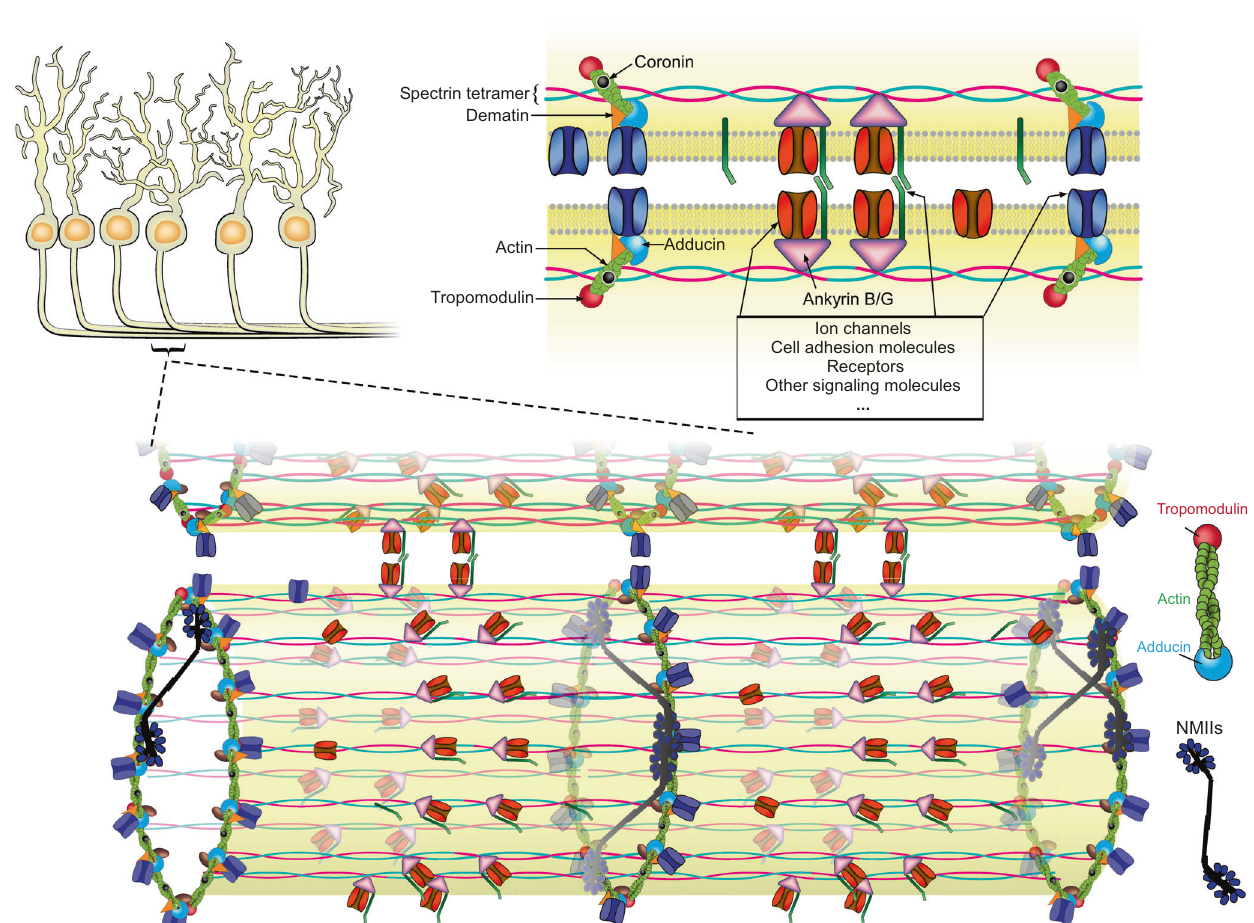
Fig. 6 Molecular architecture model of the neuronal MPS in the neurite-neurite fasciculations. In neurites, actin fi laments form ring-like structures that are connected by spectrin tetramers, and actin fi laments in these rings are likely capped by adducin and tropomodulin at their fast- and slow-growing ends, respectively. The length and structure of the actin fi laments within the actin rings remains an open question and a recent electron microscopy study suggested the possibility that actin rings in the AIS are made of long, intertwined actin fi laments 29 . Dematin and coronin bind to the actin fi laments, and ankyrin B and ankyrin G bind to the site near the center of each spectrin tetramer. The NMII bipolar fi laments bind preferentially to actin fi laments within the same actin rings and may regulate the diameter of neurites by exerting radial contractile forces. It is possible that a smaller fraction of NMII bipolar fi laments may connect adjacent actin rings. Membrane proteins, such as ion channels, cell adhesion molecules, receptors and signaling molecules, are associated either with the actin fi laments through adaptor proteins such as dematin, or with the center positions of spectrin tetramers through adaptor proteins such as ankyrin. Recruitment of cell adhesion molecules to periodic sites on the MPS and interactions of cell adhesion molecules between two abutting neurites bring their respective MPS structures in phase, which could in turn bring additional MPS-bound cell adhesion molecules from the two neurites into proximity, enhancing neurite-neurite interactions. Moreover, the MPS could serve as a structural platform that organizes transmembrane proteins and membrane-associated signaling molecules, potentially facilitating a variety of signaling pathways in